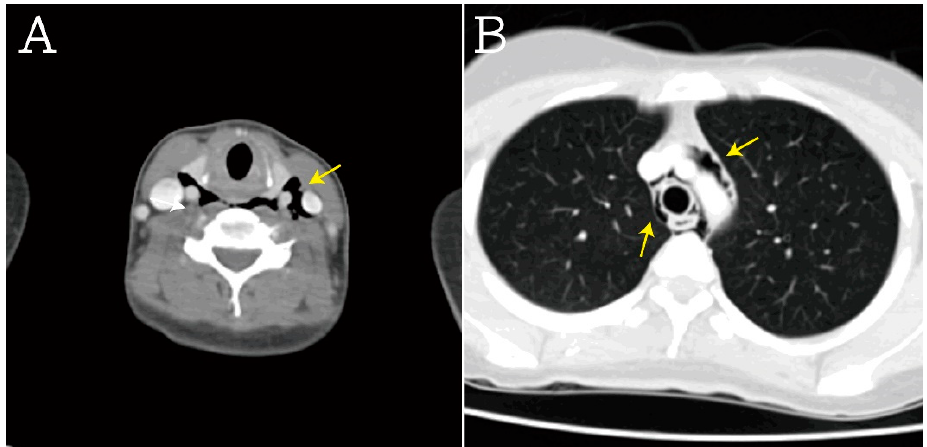
Figure 3. In computed tomography scans, these results were also noted, including ( A ) subcutane- ous emphysema (yellow arrow), ( B ) pneumomediastinum, periaortic gas, and pericardiac gas (yellow arrow).